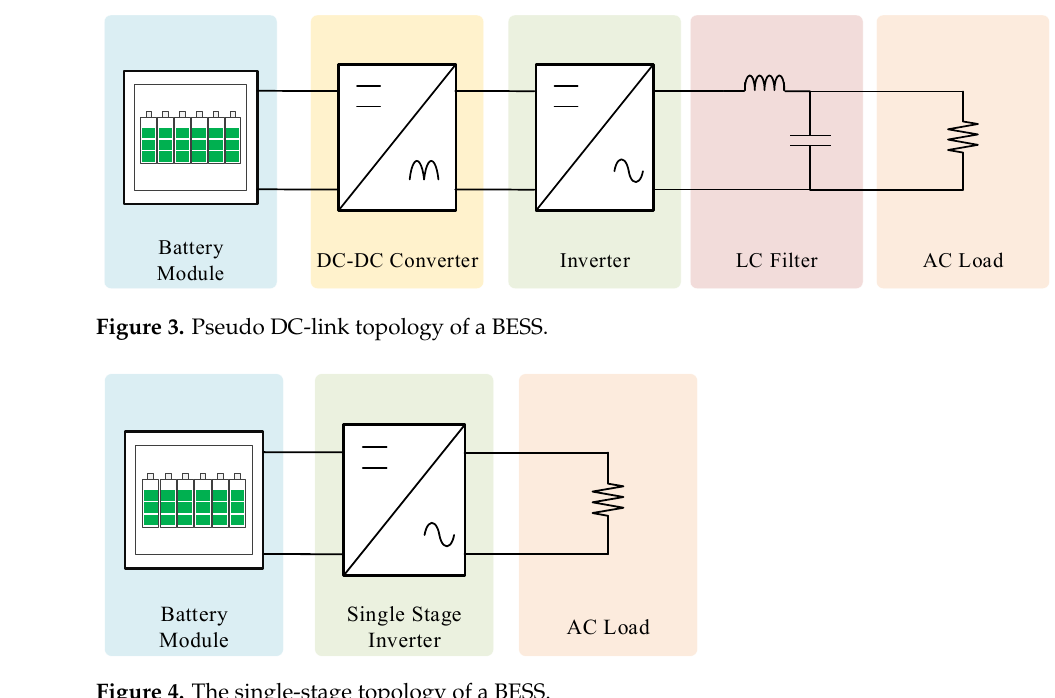
Figure 3. Pseudo DC-link topology of a BESS.